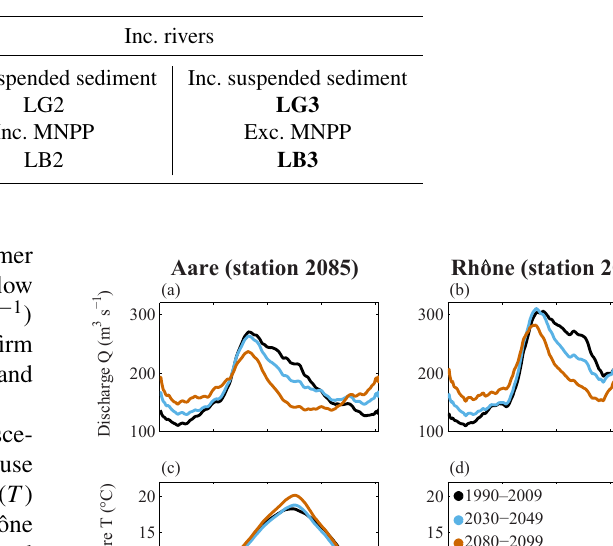
Table 4. Model scenarios of climate change effects for near-future and far-future time periods, including (Inc.) and excluding (Exc.) the effects of rivers and suspended sediment. Thermal input from MNPP was also included/excluded. Most likely scenarios are shown in bold.